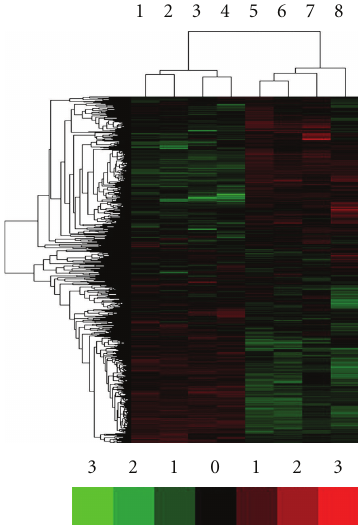
Figure 1: Genes di ff erentially expressed in BMMSCs between SLE patients and normal controls. Genes were shown by the ratio of hybridization intensity between normal control and SLE BMMSCs. The ratio ≥ 2 or ≤ 0.5 was considered significant. Genes highly expressed in BMMSCs from normal controls were highlighted in green, while those highly expressed in BMMSCs from SLE patients were highlighted in red.